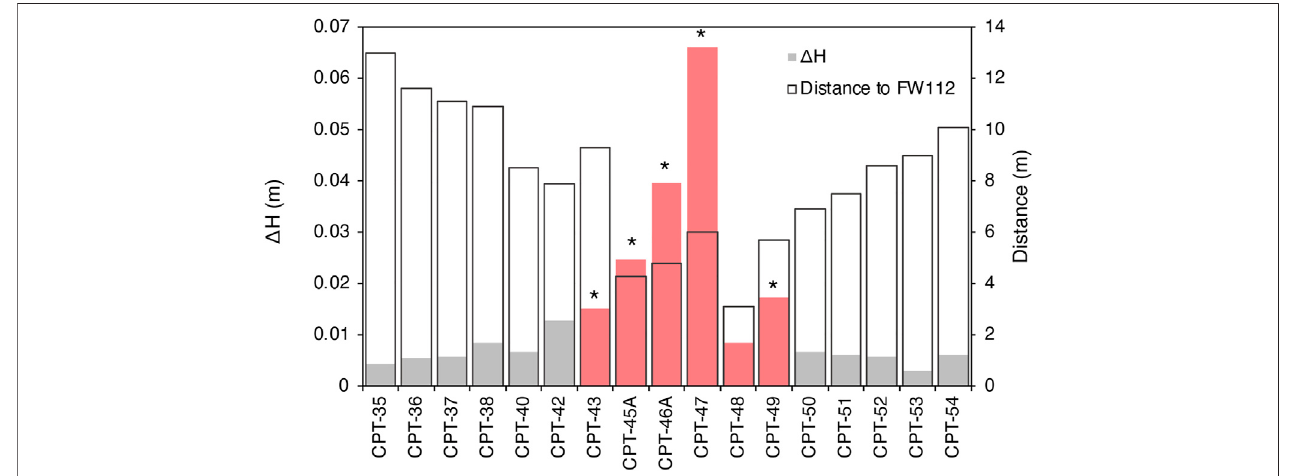
FIGURE 7 | Local CPT activity in fl uence on local water levels. Changes in water level ( Δ H) measured in FW112 during CPT activity are plotted as shaded bars, and distance between the CPT push and FW112 in transparent. Salmon colored bars indicate penetration activities which occurred South/South West of FW112, and stars (*) indicate those which were identi fi ed to have signi fi cant ( p < 0.01 ) water level variation from daily values during CPT activity based on an ANOVA test of mean signi fi cance.